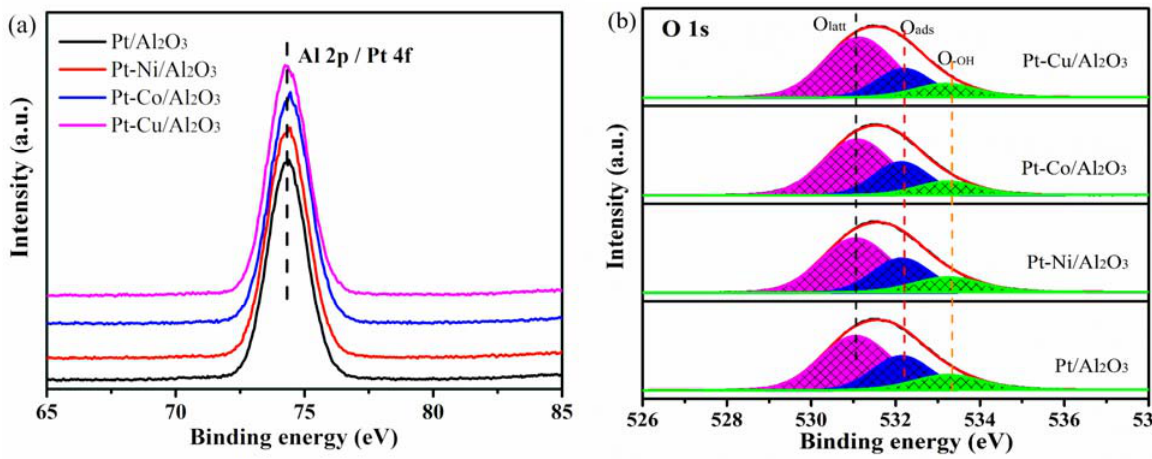
2 O 3 and Pt-M/Al 2 O 3 samples.